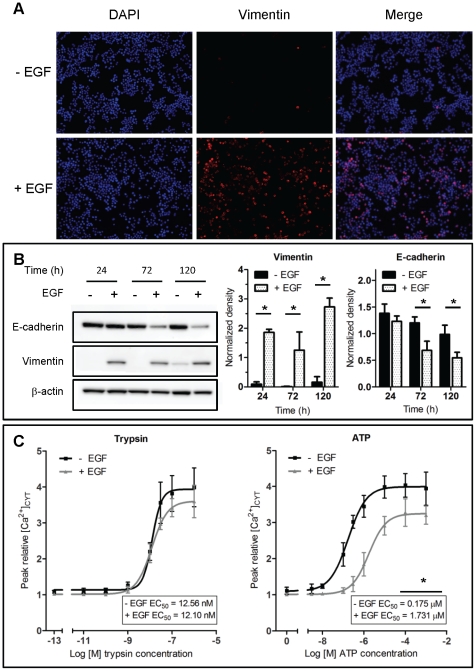
EGF-induced EMT and receptor-mediated Ca2+ signaling.MDA-MB-468 breast cancer cells were serum starved prior to treatment with EGF (50 ng/mL) or control for 24, 72 or 120 h as depicted. A, representative panel of immunofluorescence (IF) images showing vimentin expression (red) and DAPI nuclear staining (blue) following EGF stimulation (24 h). B, representative immunoblots for E-cadherin and vimentin protein after treatment with EGF (left) and pooled data (right) quantified relative to β-actin loading control. Pooled values represent mean ± S.D. for 6 pooled wells performed in triplicate in independent experiments. Statistical analysis was performed using two-way ANOVA with Bonferroni post-tests and * signifies P<0.05. C, assessment of [Ca2+]CYT in MDA-MB-468 cells treated with EGF (24 h) following stimulation with various concentrations of either trypsin (PAR2 activation) or ATP (P2 receptor activation). Graphs represent the average dose response curves for measurement of peak relative [Ca2+]CYT for 9 wells from 3 independent experiments and are shown ± S.D. Average EC50 values are shown inset and * represents the significance for EC50 values, P<0.05, unpaired t-test.